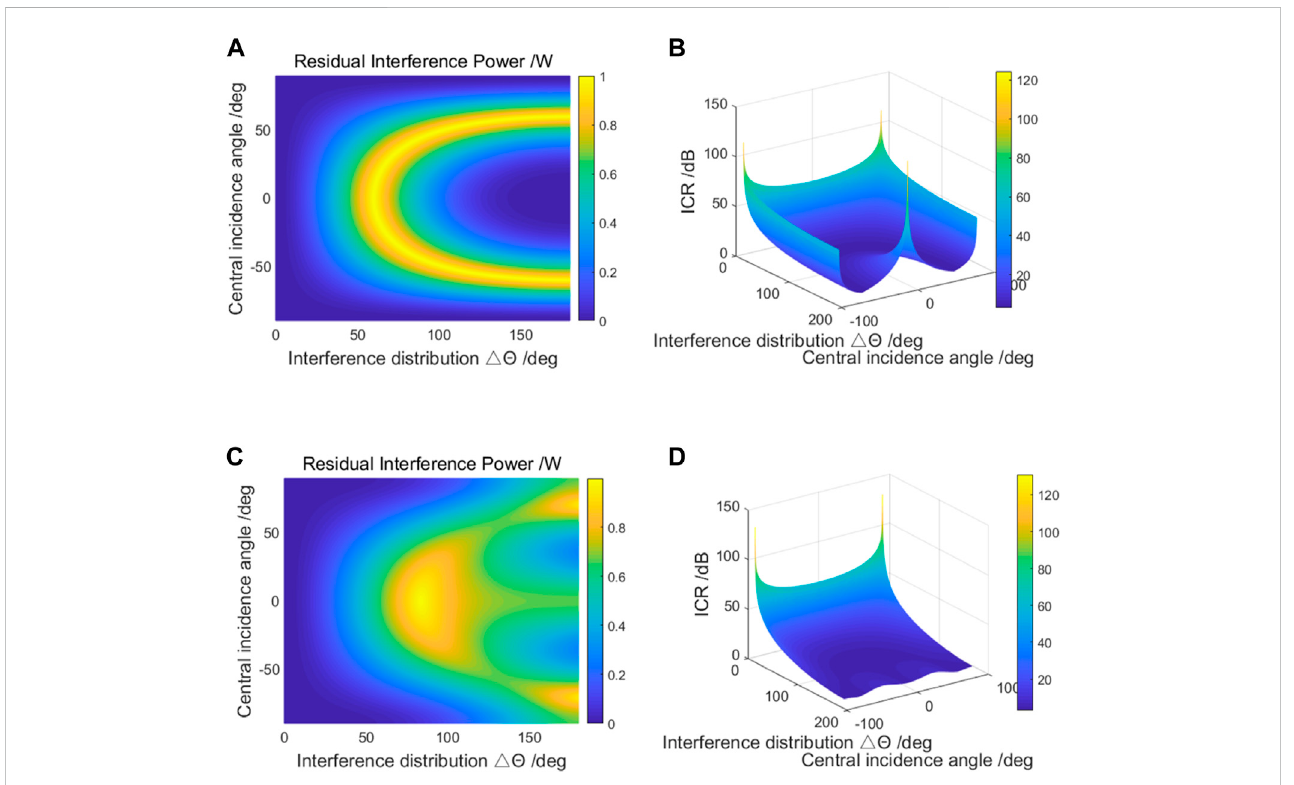
FIGURE 5 The variation of residual interference power and ICR against the interference distributionand central incident direction (two-element array). (A) Optimal residual interference power of con fi g ① ; (B) ICR of con fi g ① ; (C) Optimal residual interference power of con fi g ② ; (D) ICR of con fi g ②